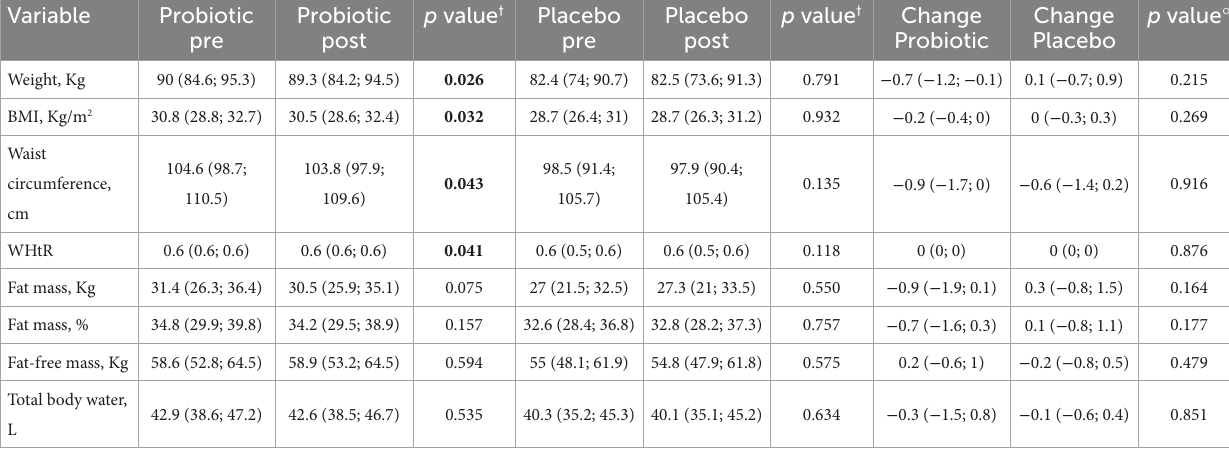
TABLE 2 Effects of the probiotic and placebo on body composition. Variable Probiotic